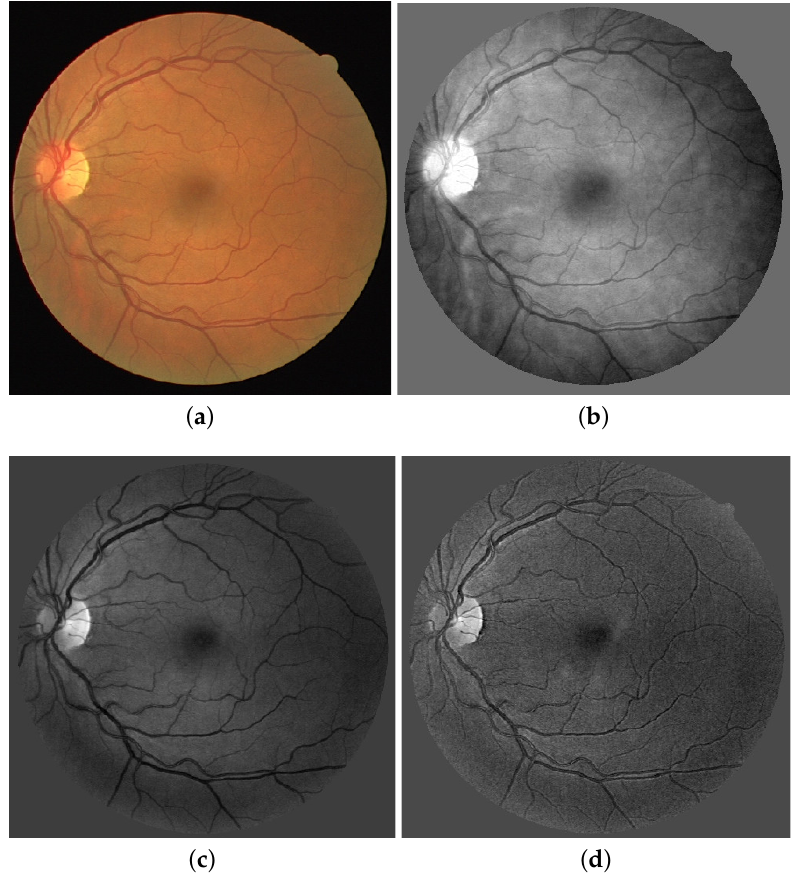
Figure 4. Retinal Image Processing ( a ) Retinal Color Fundus Image Processing. ( b ) Image of the Retinal Color Fundus in the Red Channel. ( c ) Image of the Retinal Color Fundus in the Green Channel ( d ) Image of the Retinal Color Fundus in Blue